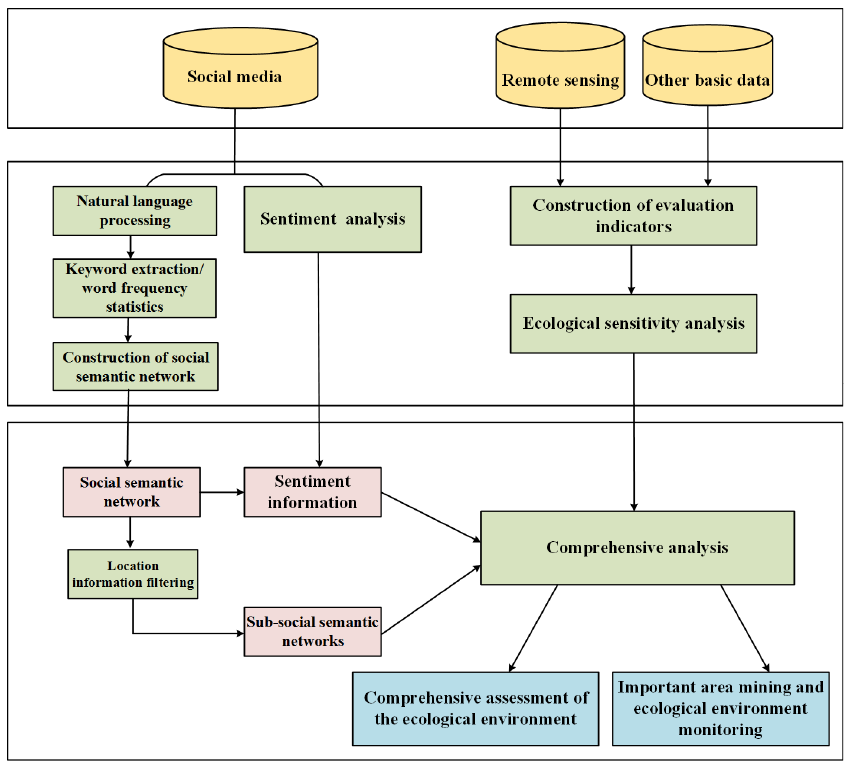
Figure 2. The structure of the proposed framework.